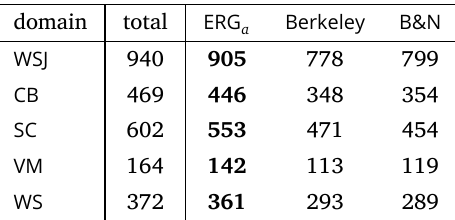
Number of total and correct analyses of prepositional complement